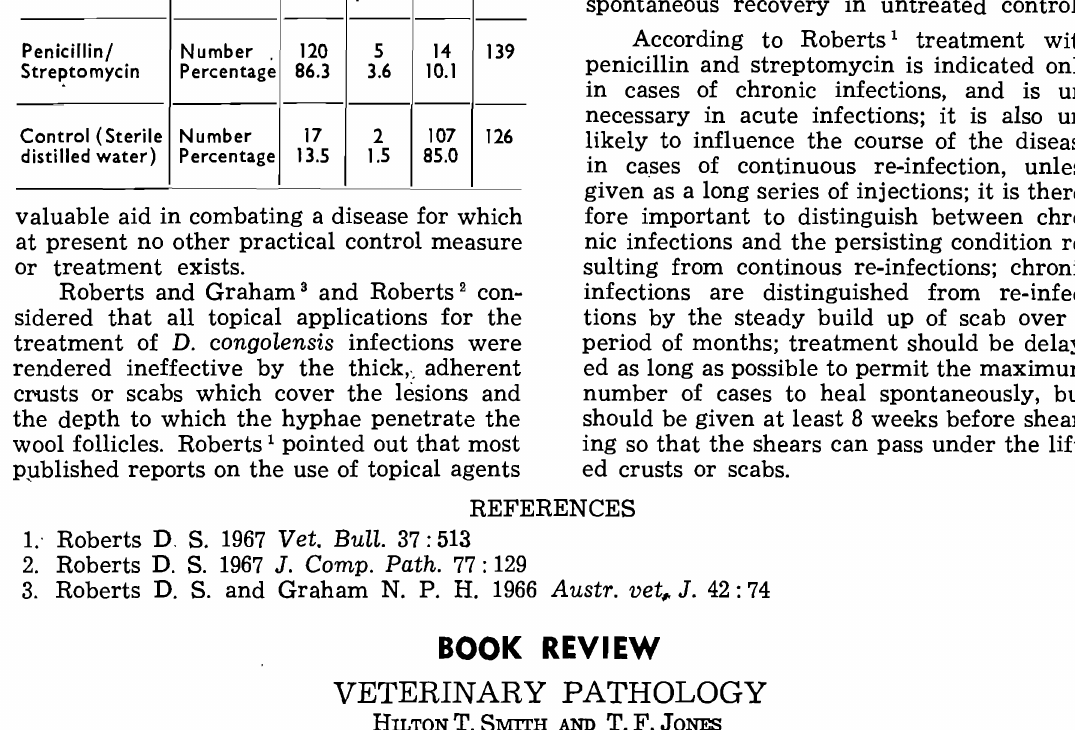
Table 1: THE RESULTS OF TREATING SHEEP CHRONICALLY INFECTED WITH LUMPY WOOL USING A COMBINATION OF PENICILLIN AND